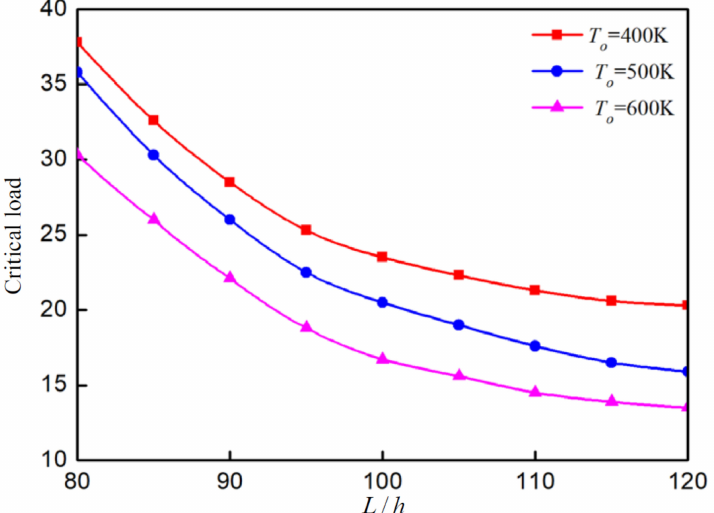
Figure 3. Critical in-plane load versus the ratio of length to thickness L / h with different temperature